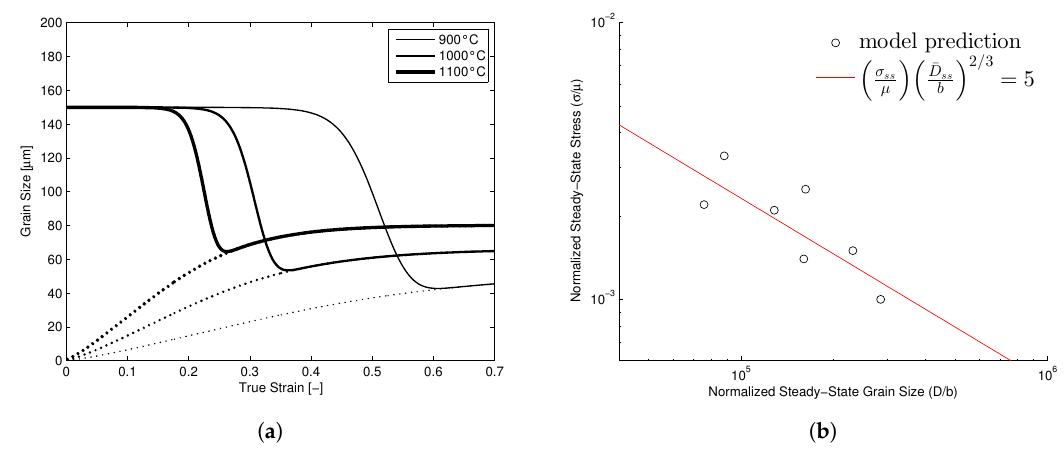
Figure 6. ( a ) Grain size evolution for three temperatures at strain rate 10 − 3 s − 1 in which the solid lines represent D a and the dotted lines represent ¯ D . ( b ) Predicted relation between normalized steady state stress and grain